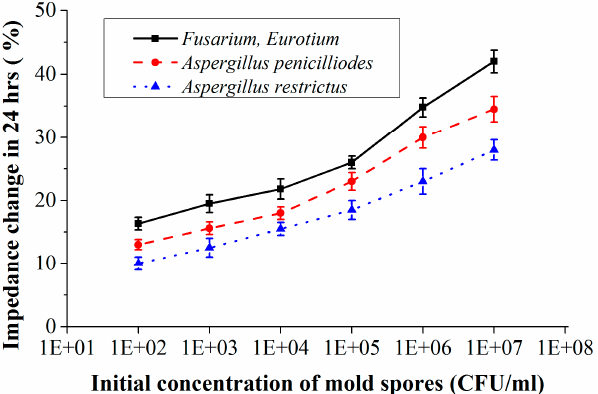
Figure 12. Percentage of impedance change as a function of initial concentration of the mold spores for a detection time of 24 h (impedance measured with CF-electrode at 10 kHz).